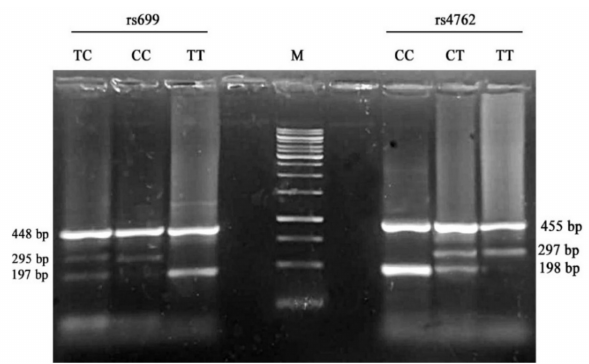
Figure 1. Representative digital photograph of ARMS-PCR products resolved on 2.0% agarose gel electrophoresis showing the AGT (rs699 and rs4762) genotyping; M, O’Gene Ruler™ 100 bp DNA ladders (Thermo Fisher Scientific, Austin, TX,